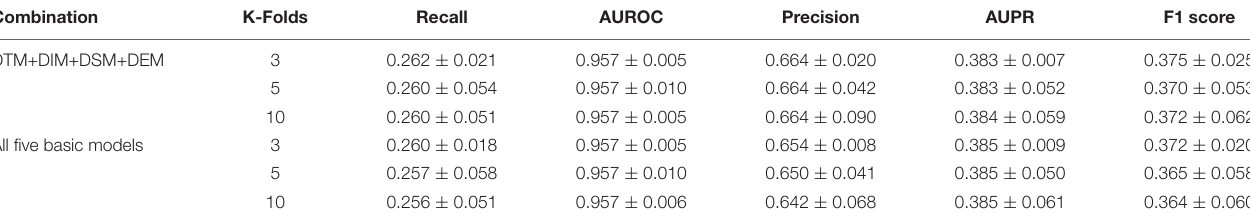
TABLE 2 | Performances of ensemble models. Combination